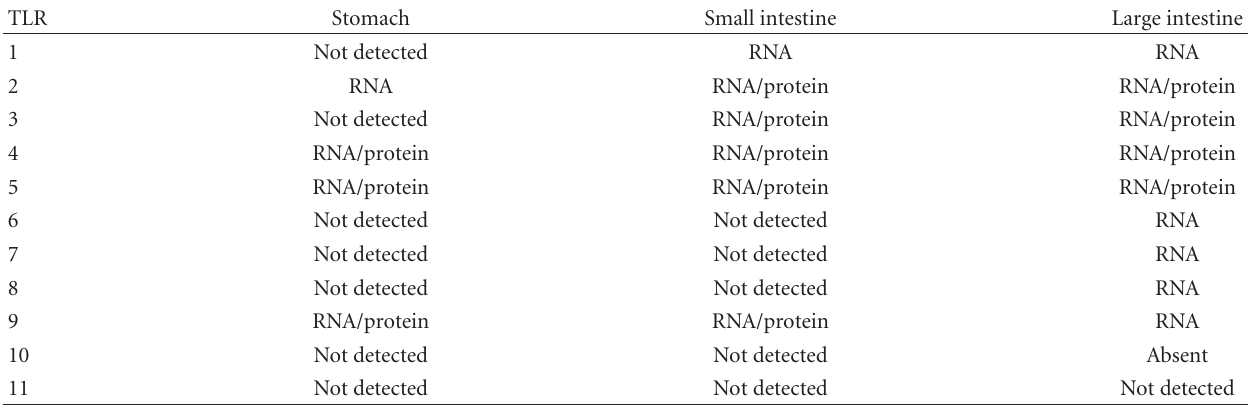
Table 2: TLR expression within the gastrointestinal tract. (Adapted from Fukata and Abreu 2008 and Gribar et al. 2008) [11, 19].